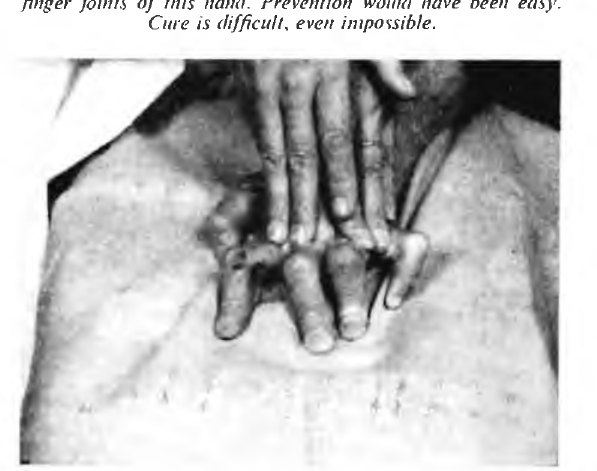
Fig. 5 — Structural contractures have occurred at thumb and finger joints o f this hand. Prevention would have been easy. Cure is difficult, even